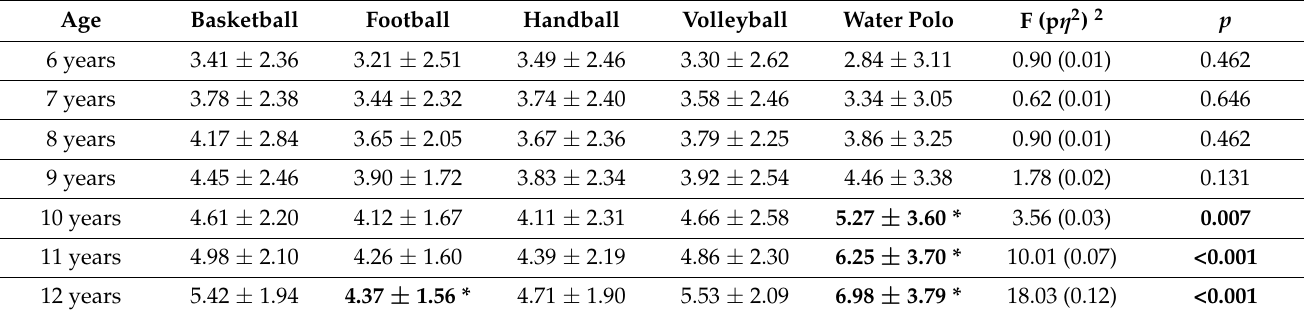
Table 4. Number of hours of training per week according to age and